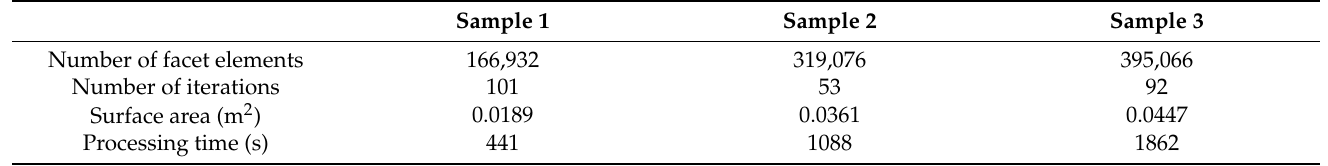
Table 3. Number of facets, number of iterations, and processing times for samples 1, 2, and